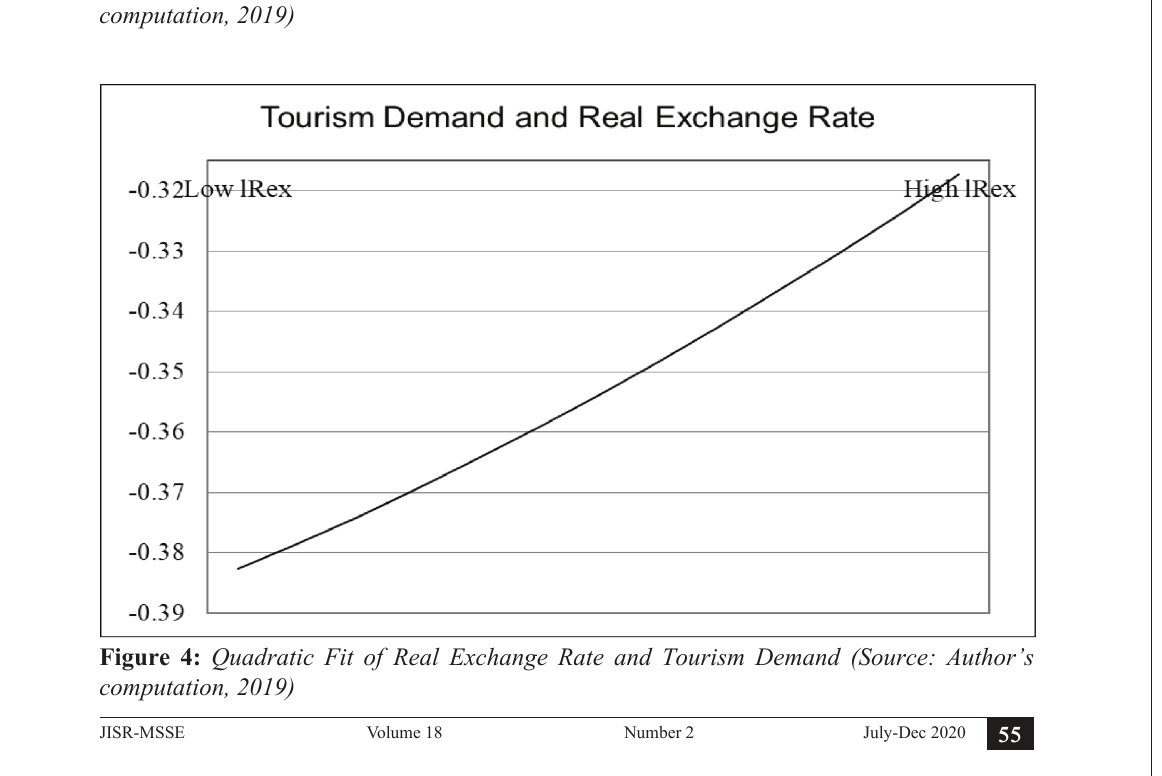
Figure 3: Quadratic Fit of Environment Quality and Tourism Demand (Source: Author’s computation, 2019)